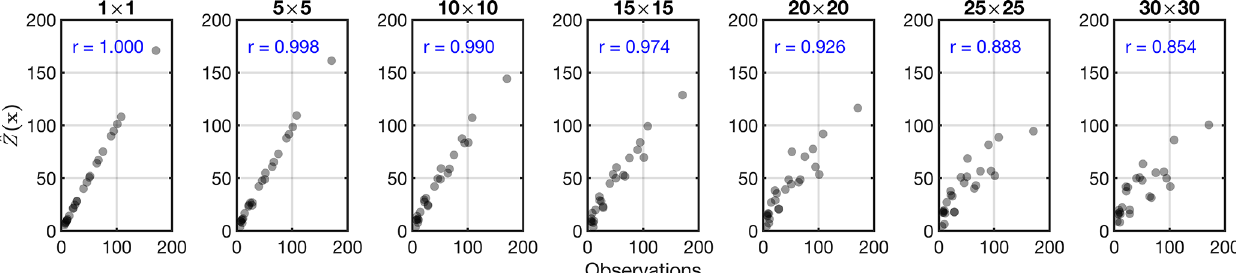
Figure 7. Illustrating the problem of spatial scale: comparisons of the kriging estimates at seven different spatial scales with the samples used for the C5opt estimation. The perceived discrepancies are purely due to the spatial representativeness.